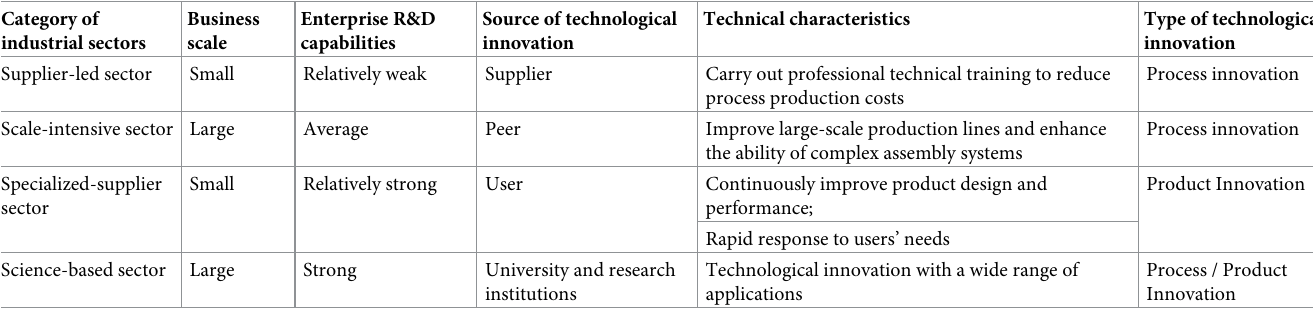
Table 1. Enterprise innovation characteristics based on Pavitt industry